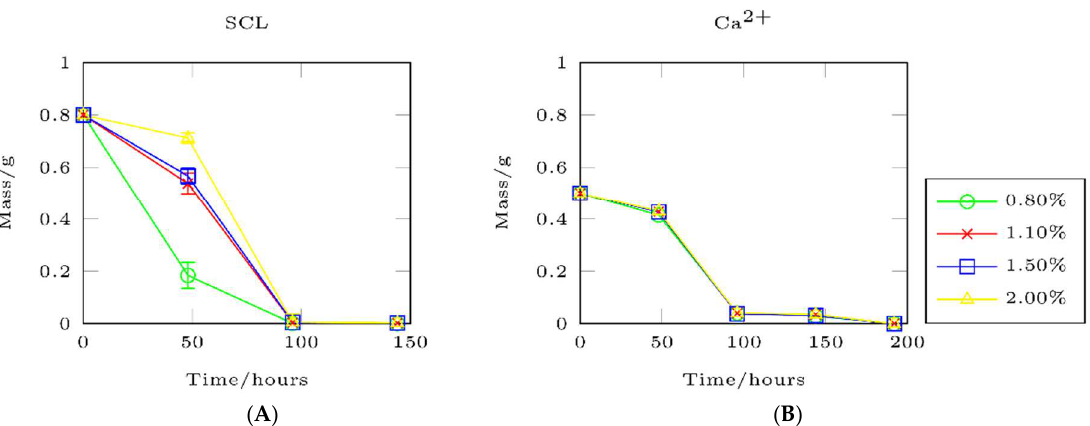
Figure 3. ConfirmedDegradation profiles of SCL and Ca 2+ hydrogels. 0.8%, 1.1%, 1.5%, and 2% are the concentrations of alginate in both types of hydrogels, and the varying concentrations of alginate present for the different groups of hydrogels. (A) The mass change of SCL hydrogels with hours. (B) The mass change of Ca 2+ hydrogels with hours.